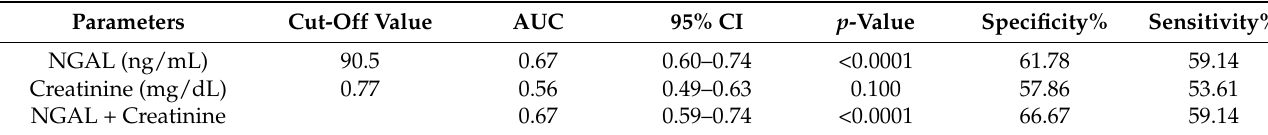
Figure 2. Intensive care unit (ICU) admission levels of NGAL and creatinine. ( A ) NGAL and ( B ) creatinine were measured at ICU admission (within 24 h) in 98 critically ill patients who eventually developed AKI in the ICU and in 168 patients who did not. Two-group comparisons were performed with the non-parametric Mann–Whitney test, **** p < 0.0001. Data are presented as violin plots, indicating the median value, and 25th and 75th centiles. Definition of abbreviations: AKI = Acute kidney injury; NGAL = Neutrophil gelatinase-associated lipocalin. Table 2. Prognostic values of AKI